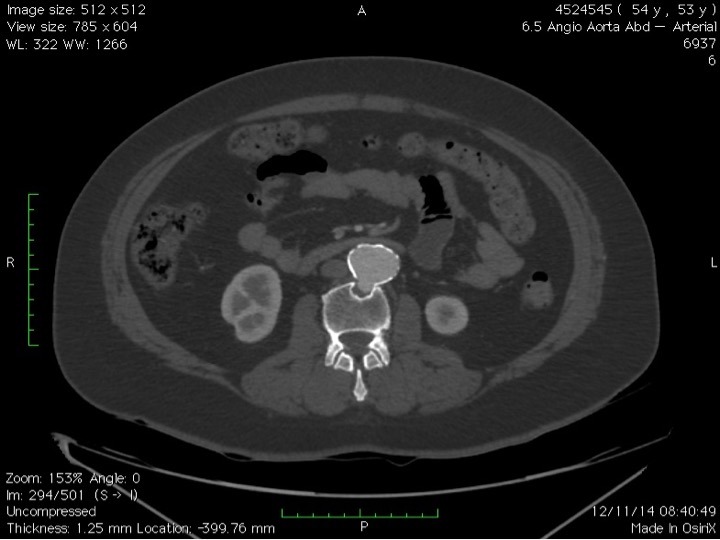
Preoperative axial angiotomography showing aortic aneurysm with erosion of lumbar vertebra.